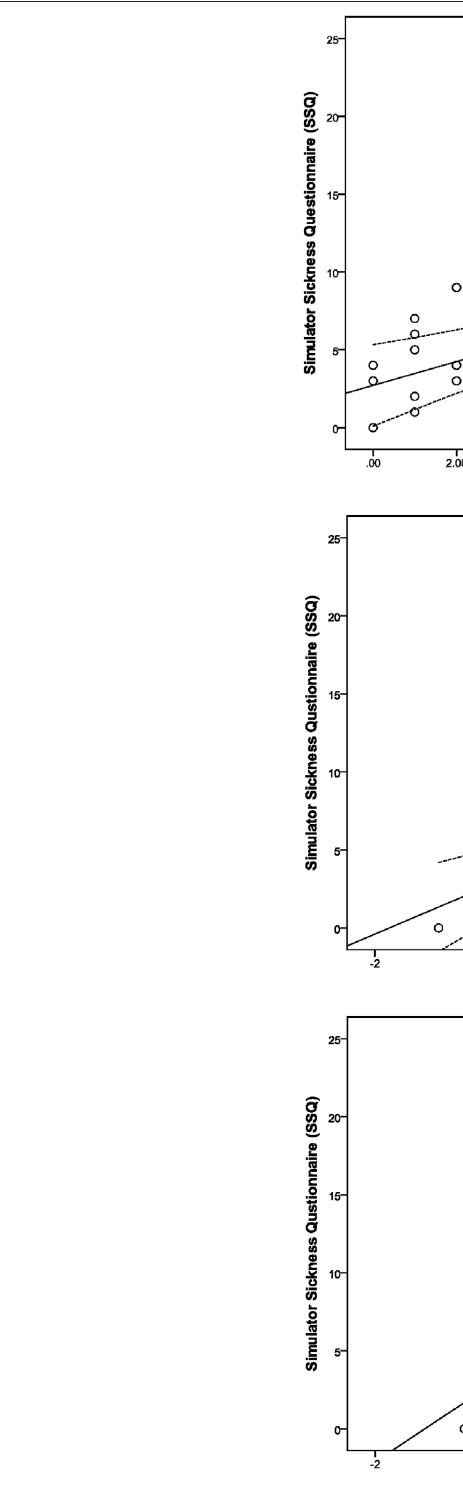
Frontiers in Virtual Reality |